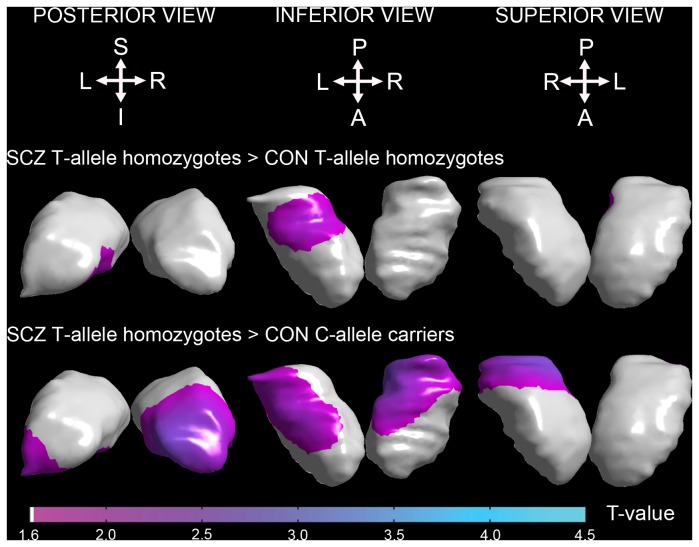
Statistical maps of thalamic shape differences between schizophrenia T-allele homozygotes and control T-allele homozygotes (top panel); schizophrenia T-allele homozygotes and control C-allele carriers (middle panel).T-values are shown only in the regions with significant group differences after the correction of multiple comparisons. Keys: S – superior; I – inferior; A – anterior; P – posterior; L – left; R – right.